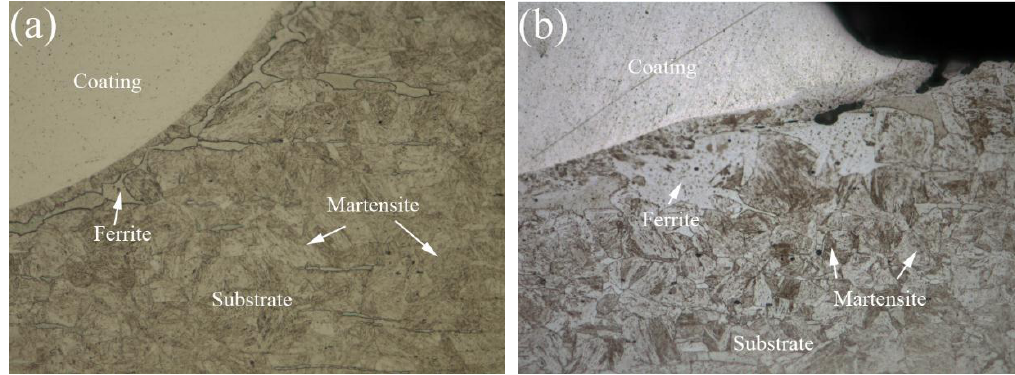
Figure 4. ( a ) OM microstructure of the monolayer and ( b ) trilayer coatings.